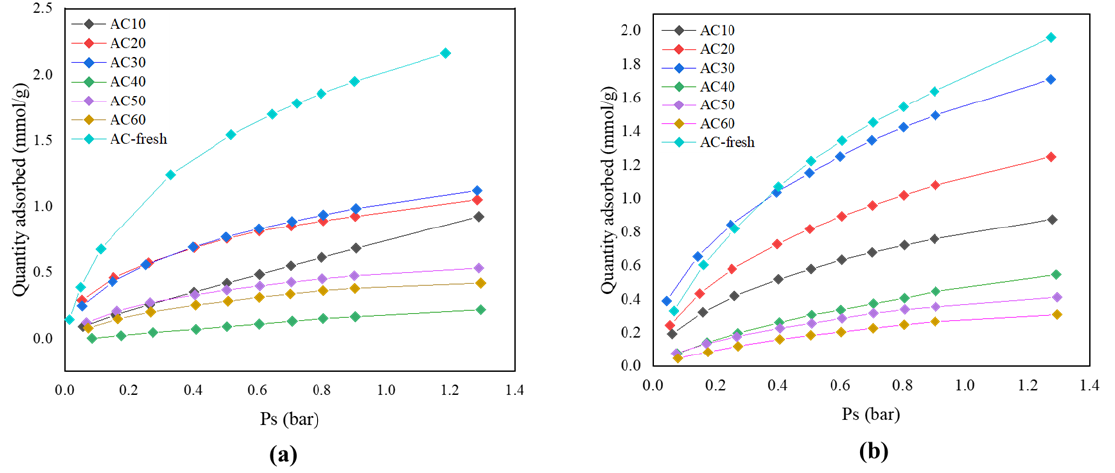
Figure 9. CO 2 adsorption capacity of fresh and functionalized AC obtained at ( a ) 25 °C and ( b ) 40 °C.